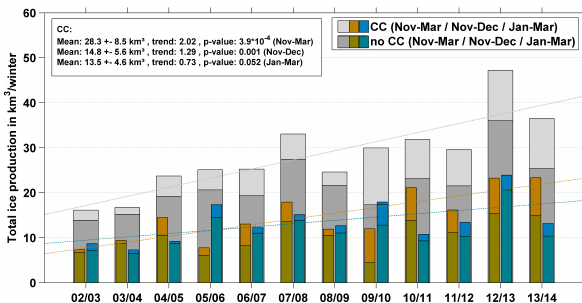
Figure 9. Annual wintertime accumulated ice production in the Storfjorden polynya, given in cubic kilometers per winter. Estima- tions are based on daily heat flux calculations using the daily de- rived thin-ice thickness (TIT) composites. Special emphasis is given to the effect of an applied coverage correction (CC). Dotted lines show linear trend estimations for IP CC . Colored bars show a sea- sonal comparison between November and December (yellowish) and January and March